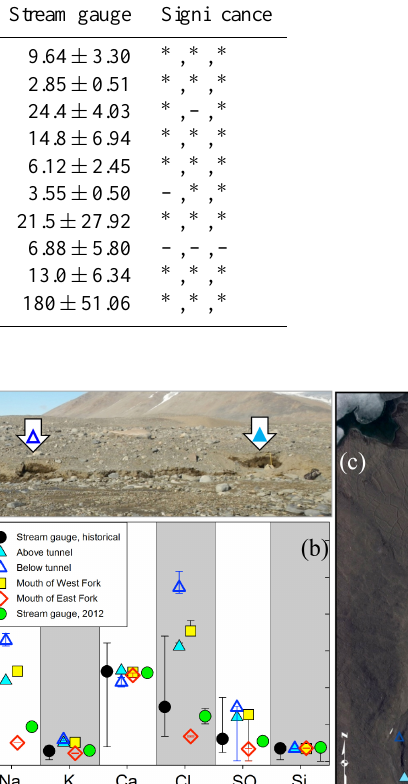
Table 1. Means and standard deviations of water chemistry parameters as observed in three groups. Comparison significance reports the result of paired t tests and Welch’s t test among three groups of data in the following order ( ∗ indicates significance with a p value<0.056): inflow to the thermokarst tunnel vs. the outflow, inflow to the thermokarst tunnel vs. the historic data collected at the gauge location, and outflow of the thermokarst tunnel vs. the historic data collected at the gauge location. means ± standard deviations Thermokarst Thermokarst Historic data Comparison Constituent Tunnel inflow Tunnel outflow from Stream gauge Significance Na 21.9 ± 0.34